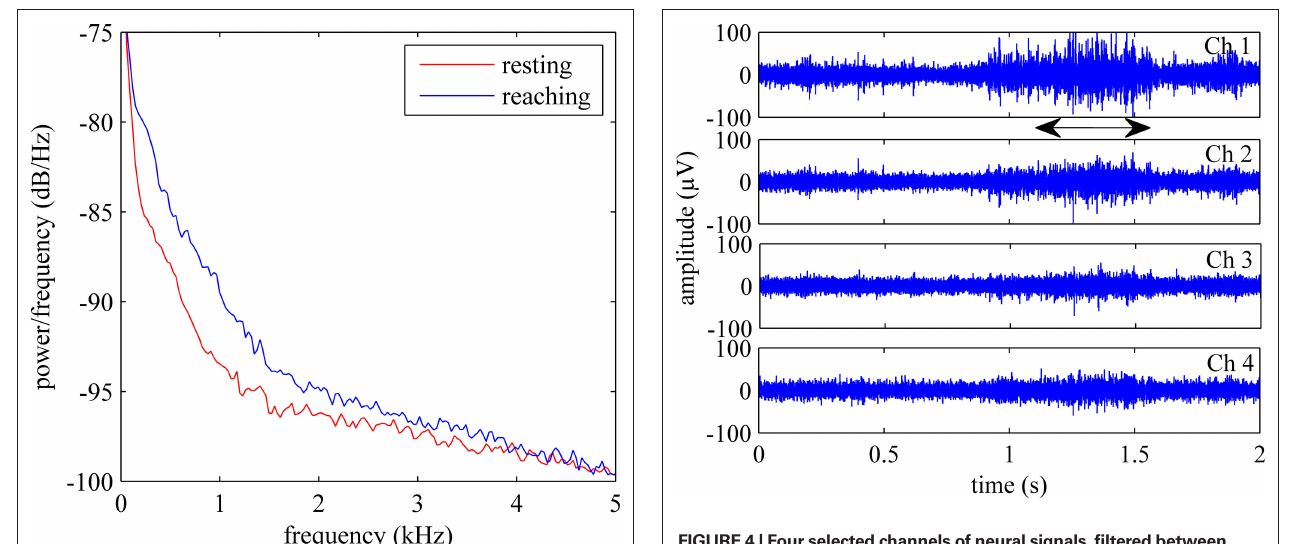
Figure 4 | Four selected channels of neural signals, filtered between 300–5000 Hz show the axonal population activity during the reaching behavior. The arrow marks the time of occurrence for the reach-to-grasp behavior.